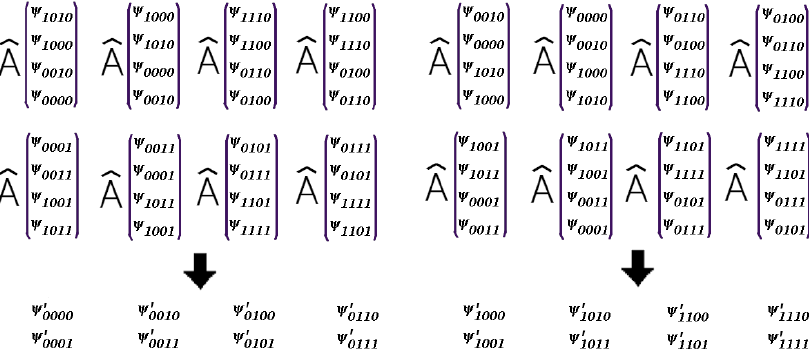
Figure 7. The computing result wave function by applying the operator ˆ A . One can note that some of (cid:126) Ψ (cid:48) the new components of are redundant. Therefore, we leave only unique components in the